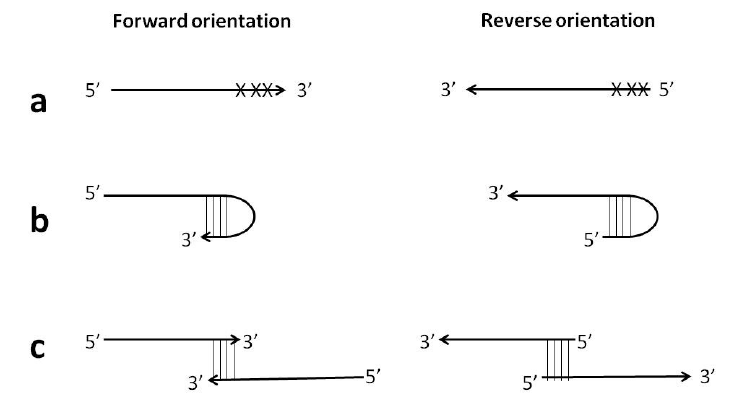
Figure 8. Examples of the reverse primer orientation feasibility: ( a ) avoidance of mismatches in close proximity to 3 ′ -end; ( b ) avoidance of hairpin formation at 3 ′ -end; ( c ) avoidance of self- or hetero-primer-dimerization at 3 ′